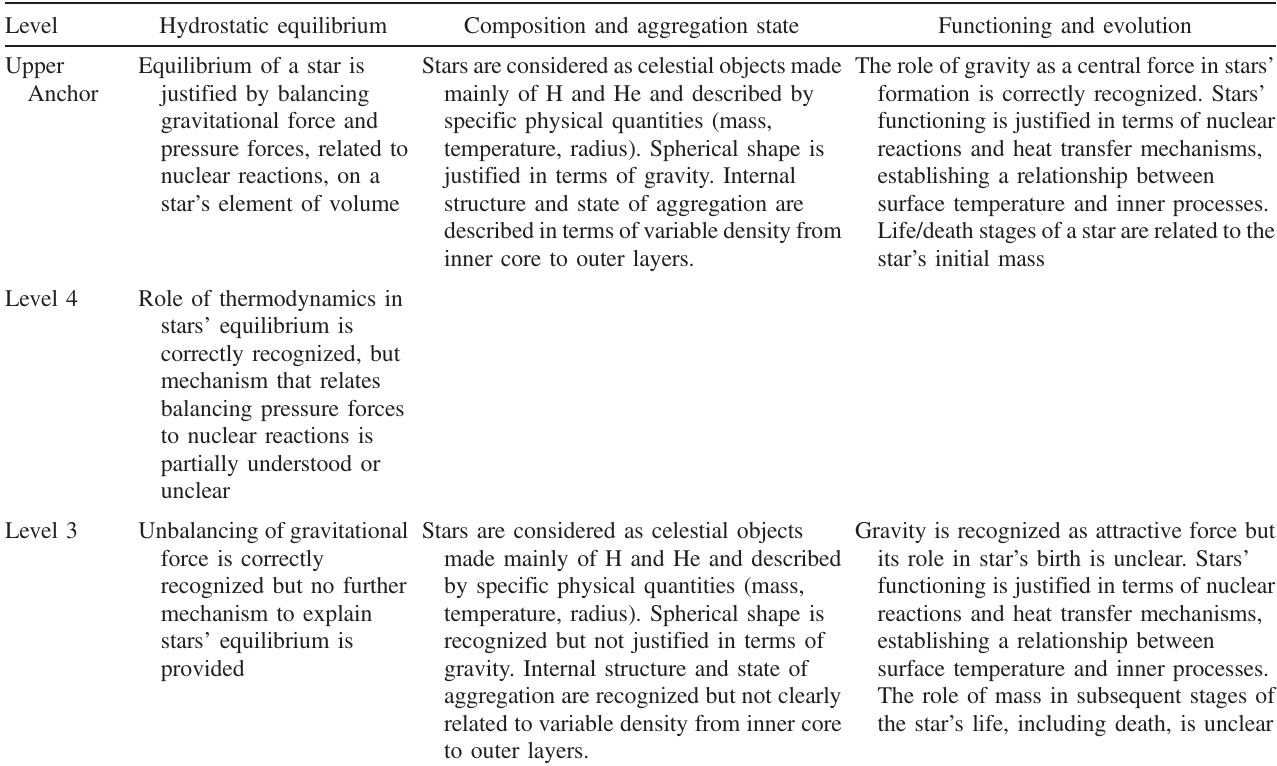
TABLE V. Revised LP about SSE (LP2). Lower anchor to level 2 are as in LP1 (Table